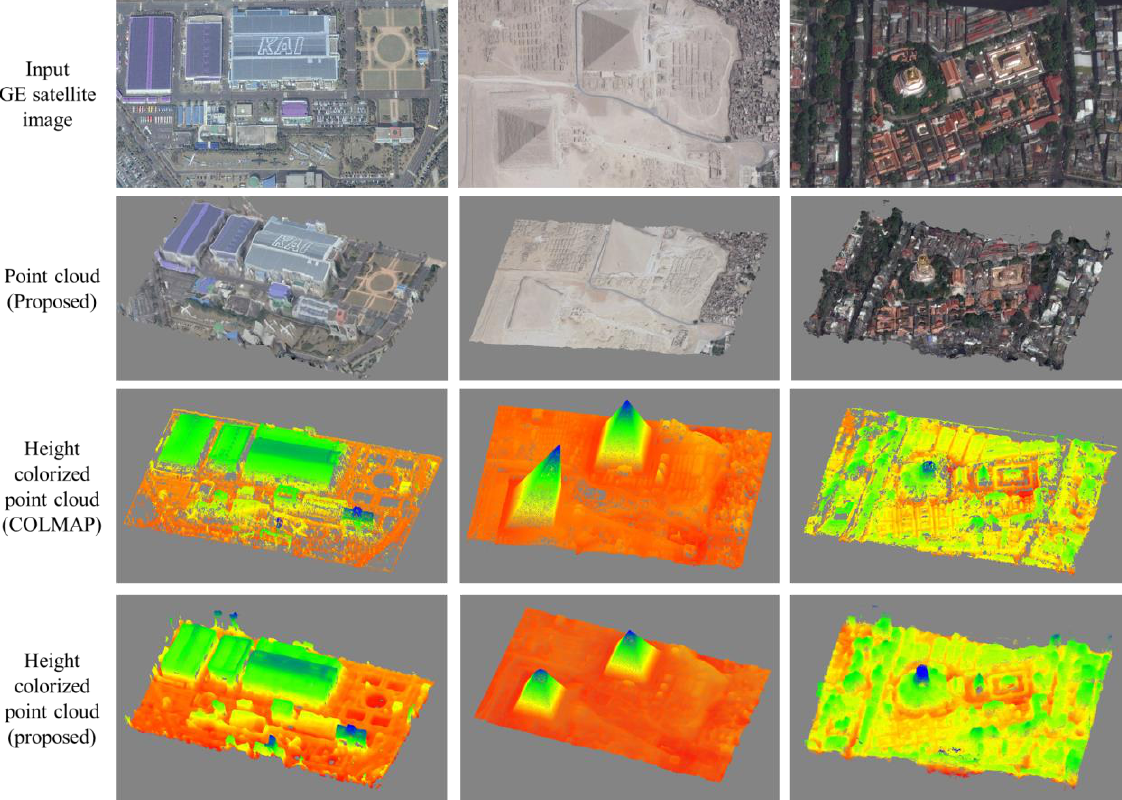
Figure 5 . The result of 3D surface reconstruction using GE satellite images (South Korea, Egypt, Bangkok). The Height colorized point cloud is the colorization about the height value (the blue color is high, and the red color is low). The EnSoft3D can obtain more dense point cloud than COLMAP. It has an advantage for generating the orthoimage using